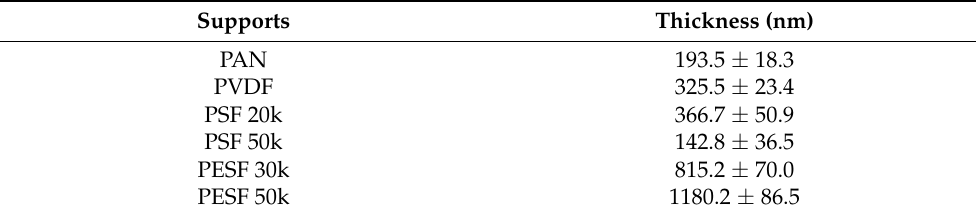
Figure 9. Cross-section and surface (inset) images of the Pebax TFC membranes coated on di ff erent supports.